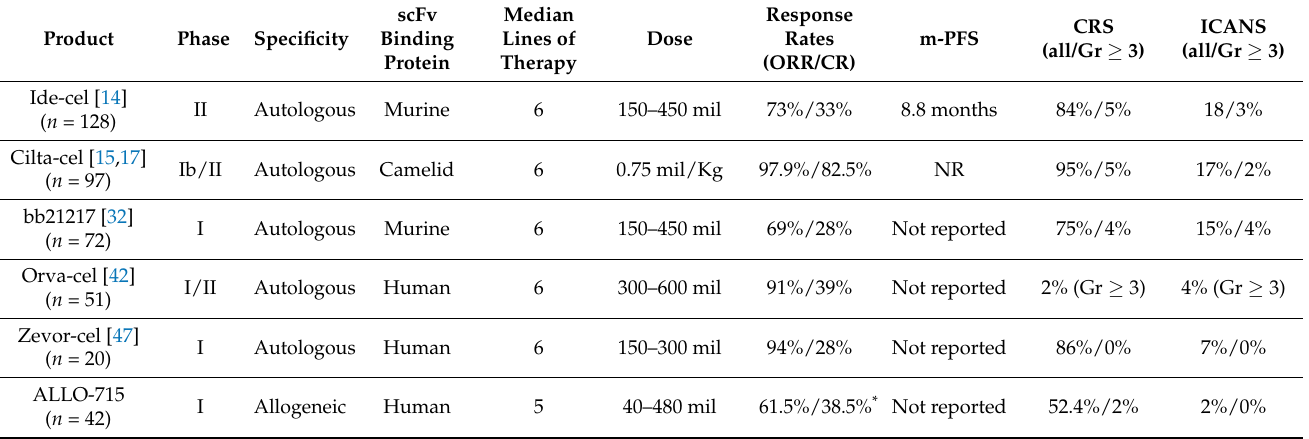
Table 1. Summary of Selected Landmark Clinical Trials of BCMA-Targeted CAR T-cells. Mil: